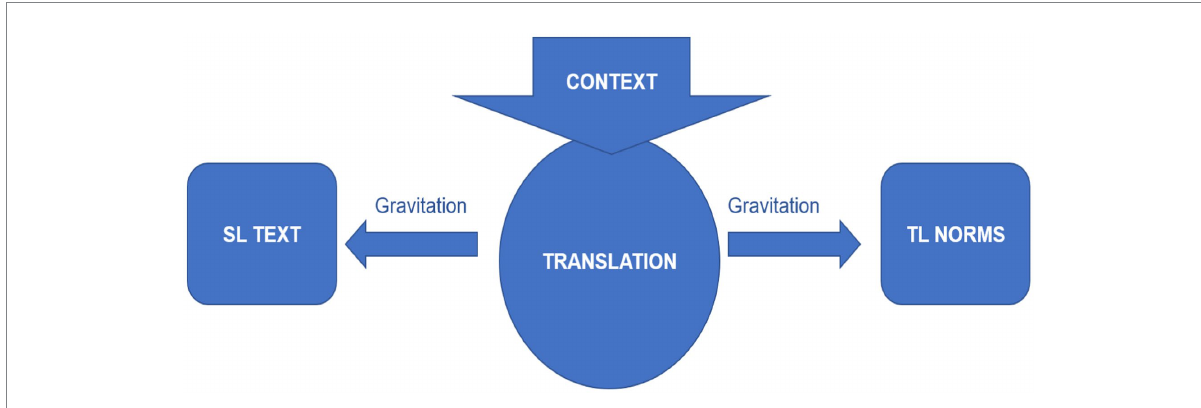
FIGURE 1 The translation process at the intersection of two attracting gravitational forces. Figure reproduced from Halverson (2003), with permission from John Benjamins